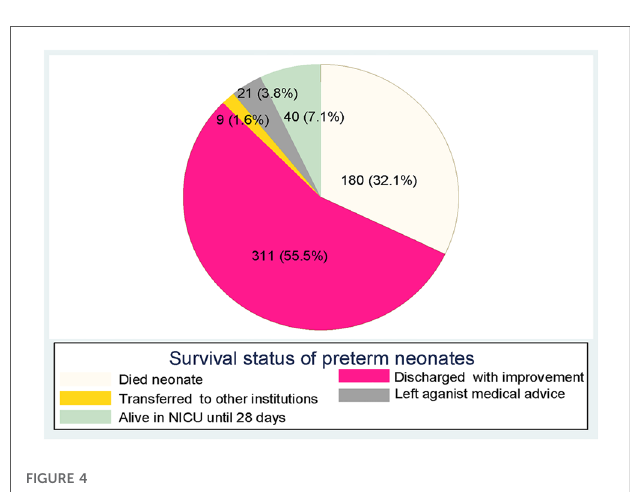
FIGURE 4 Survival status of preterm neonates at the end of follow-up in Northern Ethiopia,betweenFebruary1,2017,andJanuary30,2019,and2022( n